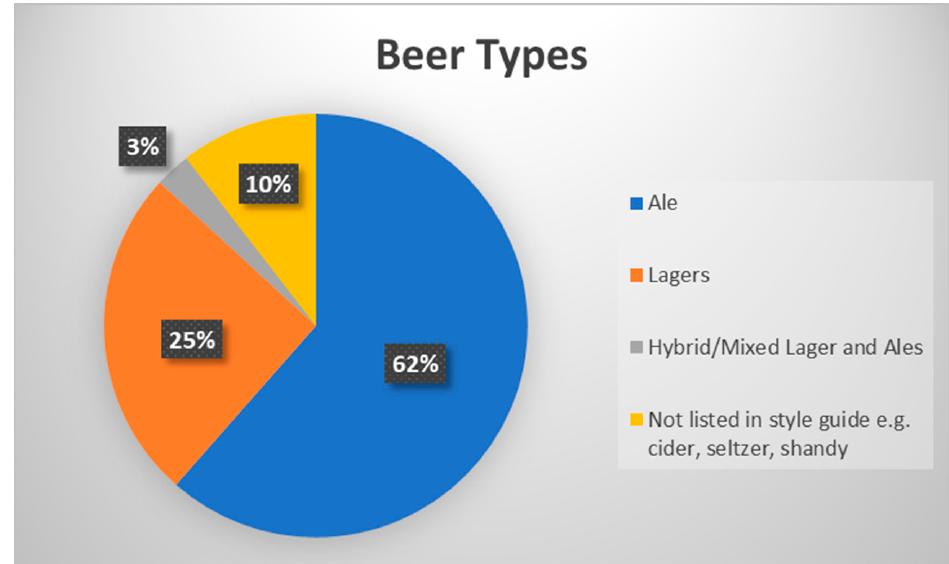
Figure 3. Beer type by percentage. (Data from the authors; pie chart constructed in Excel).